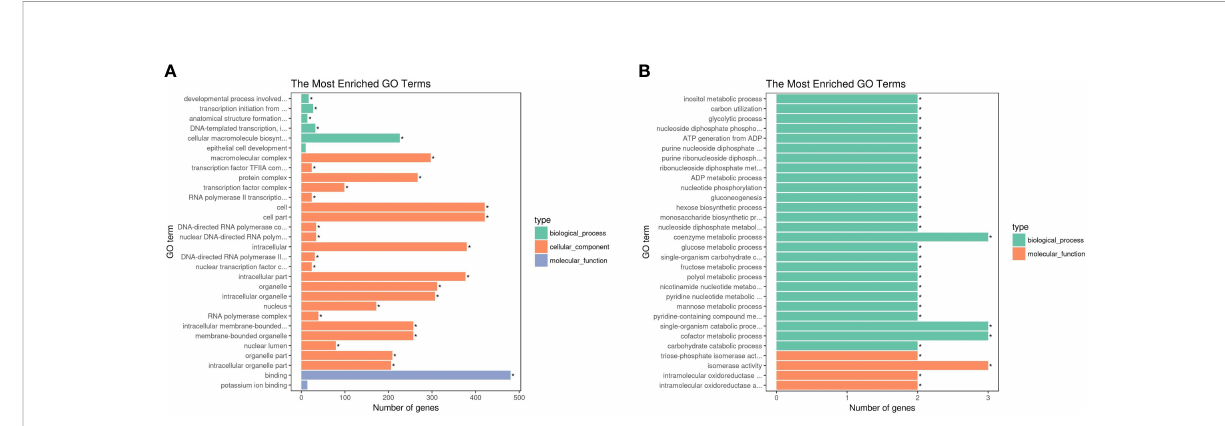
FIGURE 3 Enrichment of differentially expressed genes (DEGs) in GO (corrected P -value <0.05). (A) Downregulated DEGs that enriched GO terms in D2 dsGFP vs. D0 dsGFP . (B) Downregulated DEGs that enriched GO terms in D0 dsETH vs. D0 dsGFP . Signi fi cant difference compared with control indicated by an asterisk (P-value <0.05).